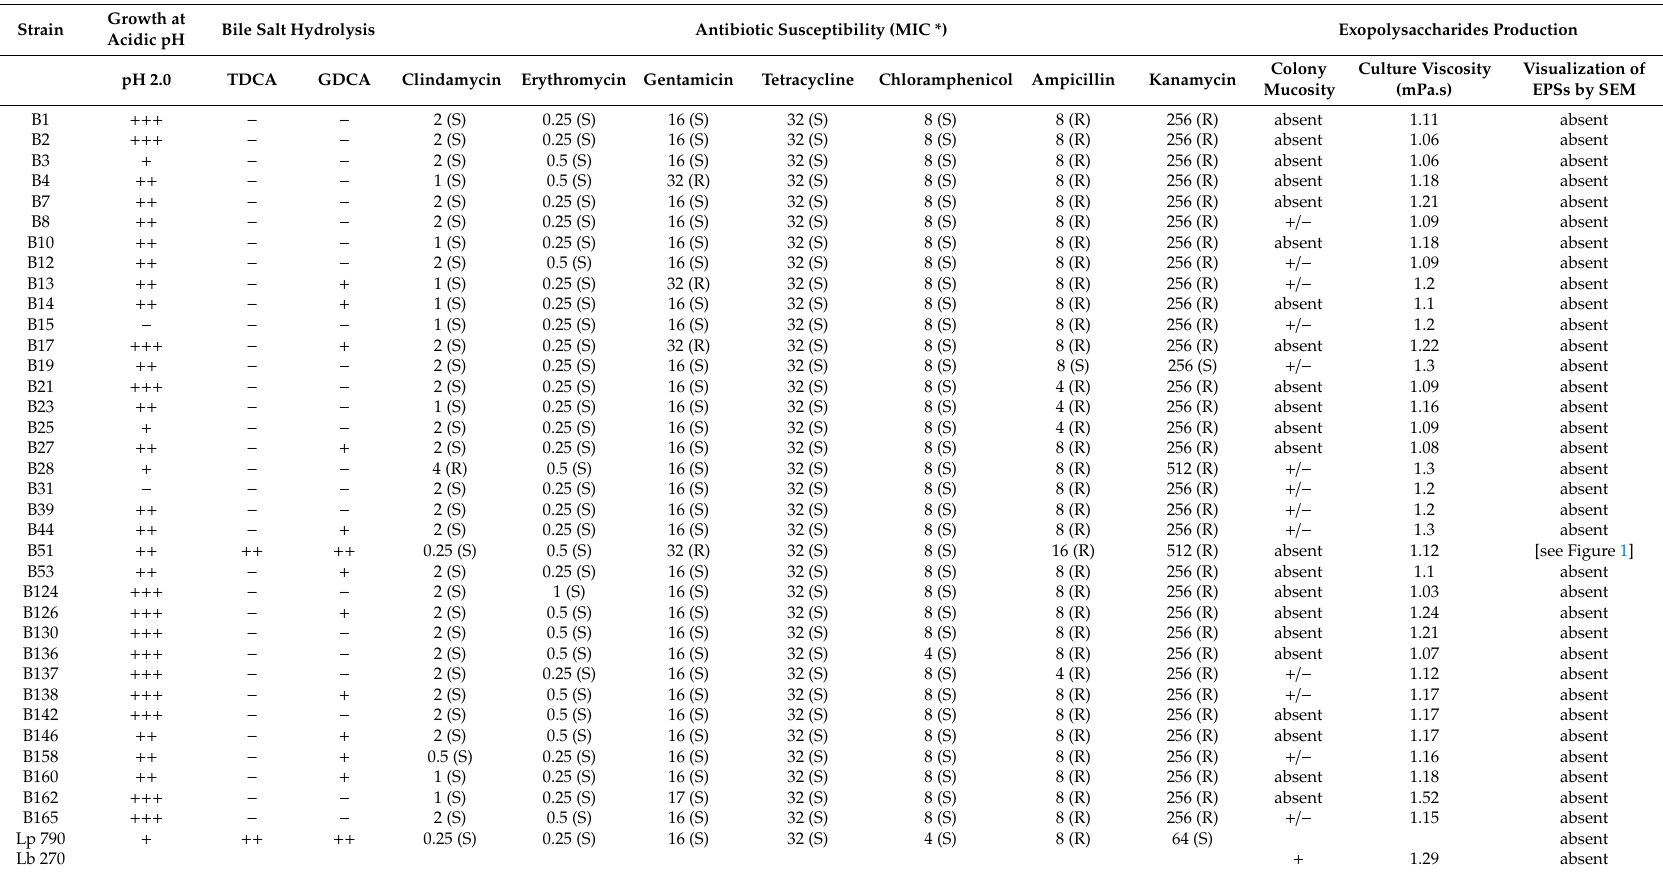
Table 2. Probiotic characterization of the LAB